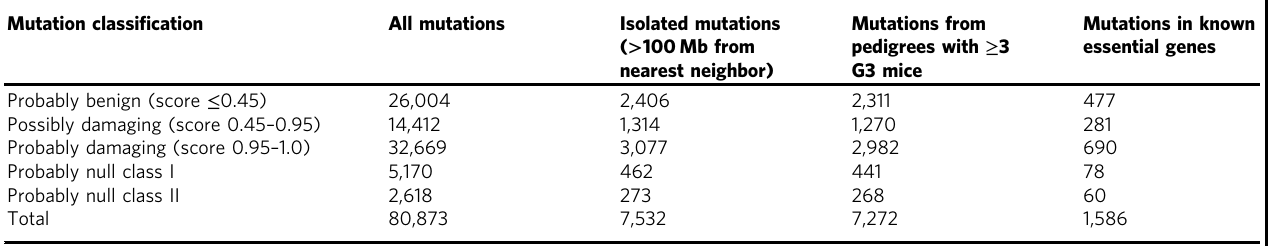
The columns represent progressive fi ltering steps from left to